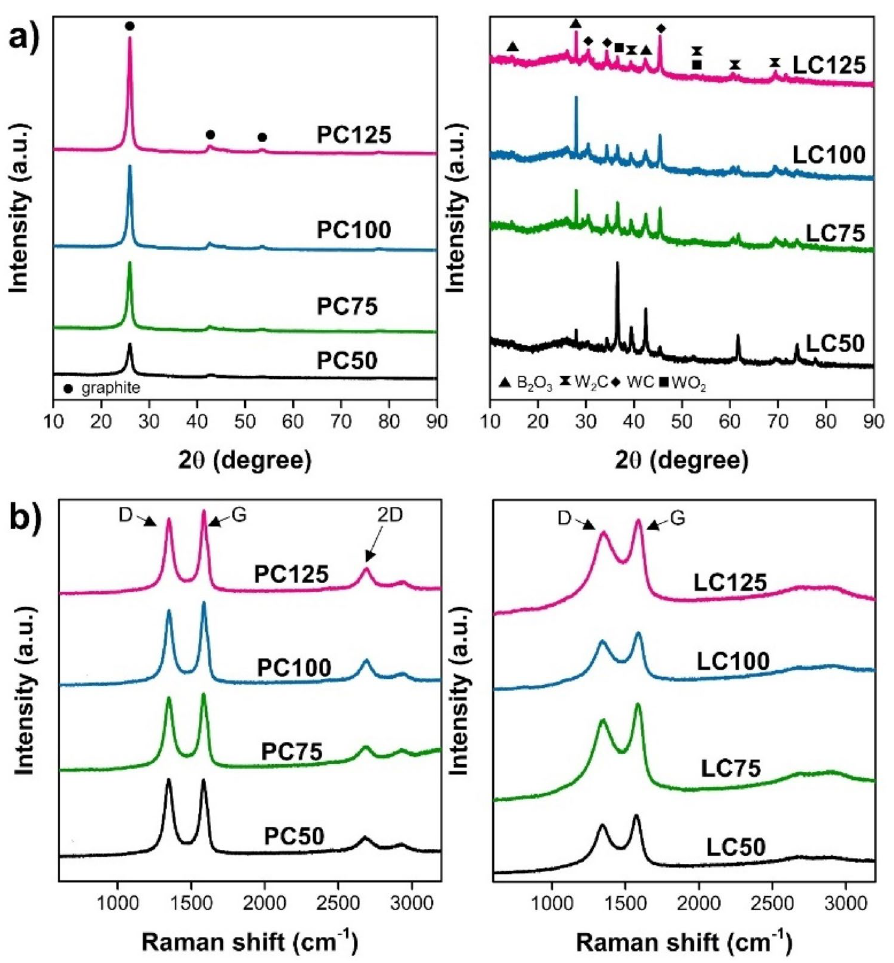
Figure 4. ( a ) XRD patterns and ( b ) Raman spectra of PC and LC synthesized from TBB via SP at frequencies of 50, 75, 100, and 125 kHz for 60 min. ( Note PC50, PC75, PC100, and PC125 refer to the PC samples prepared via SP at frequencies of 50, 75, 100, and 125 kHz, respectively. LC50, LC75, LC100, and LC125 refer to the LC samples prepared via SP at frequencies of 50, 75, 100, and 125 kHz, respectively).